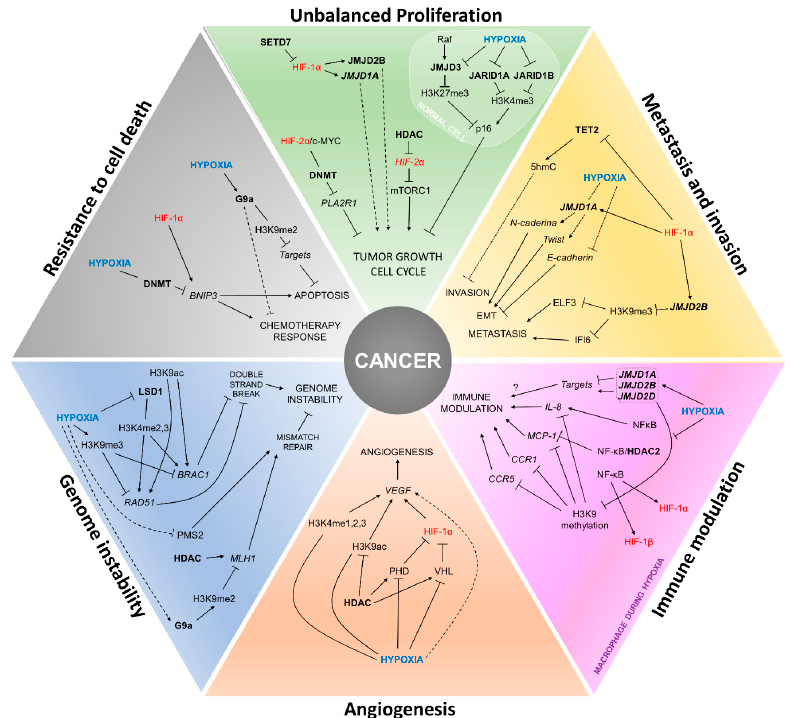
Figure 2. Interactions between hypoxia, HIFs and epigenetic players in the establishment of cancer hallmarks. The figure summarizes how the establishment of cancer hallmarks can be influenced by the cross-regulation of the expression and activity of HIFs and epigenetic modifiers during hypoxia. Text in blue: hypoxia due to low O 2 levels; text in red: hypoxia-inducible factors; text in bold: epigenetic players.